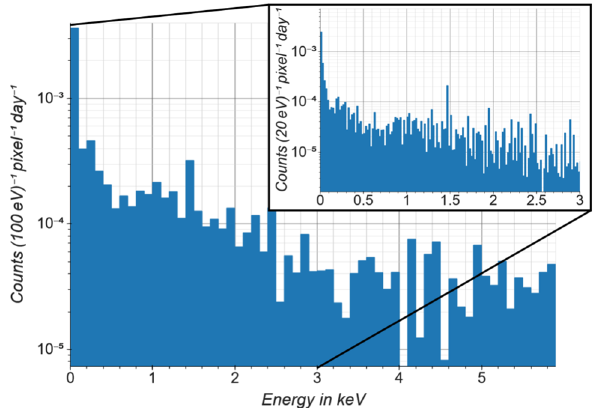
Fig. 12 Total expectedspectrum of deposited energies caused by natu- ral occurring radionuclides in materials next to the detector arrays. The only visible structure is caused by 1.486keV aluminum